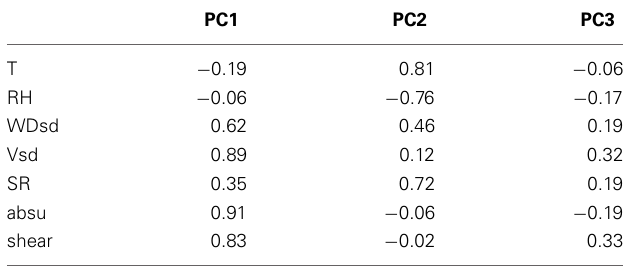
Table 1 | PC loadings from principal component analysis.